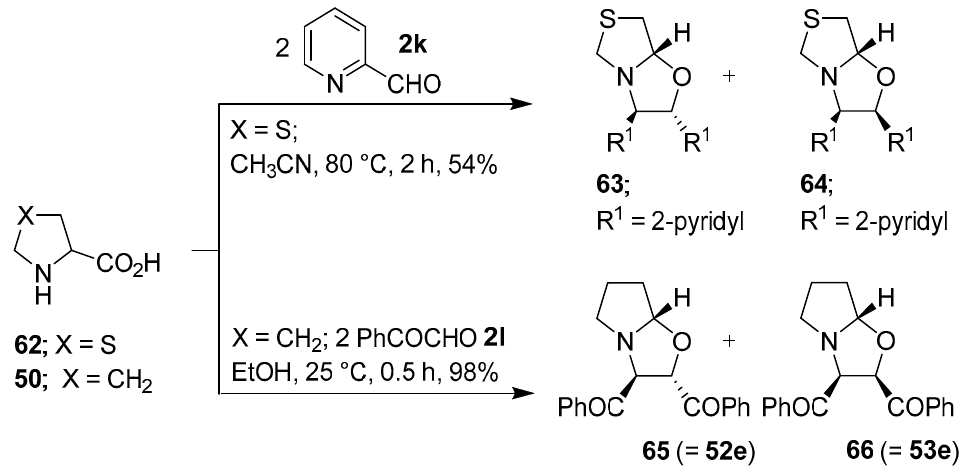
Scheme 15. Reaction of thiazolidine-4-carboxylic acid ( 62 ) with 2-pyridylcarboxaldehyde ( 2k ), and of proline ( 50 ) with phenylglyoxal ( 2l ).